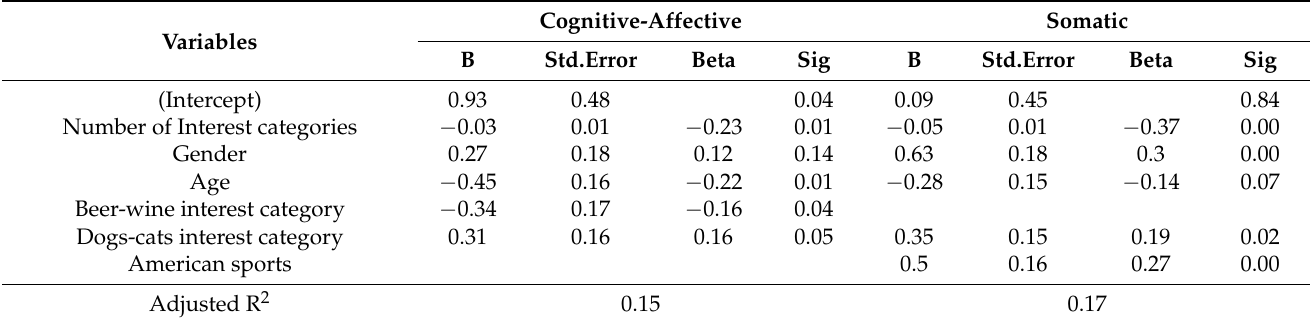
Table 8. Linear Regression models. Interest categories. Extended model.